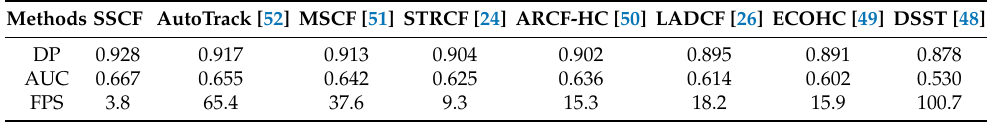
Table 3. The area under the curve (AUC), distance precision (DP) scores, and FPS of the proposed SSCF and other trackers on the UAVDT-M